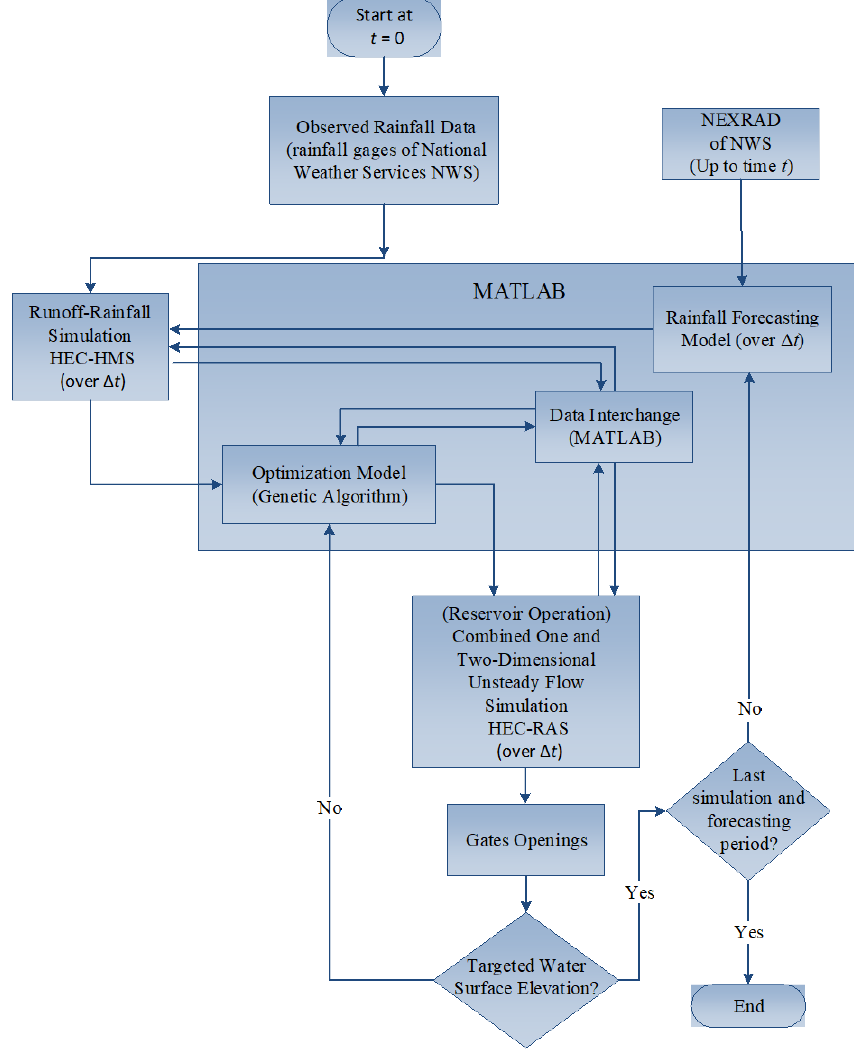
Figure 5. Basic steps of the optimization/simulation